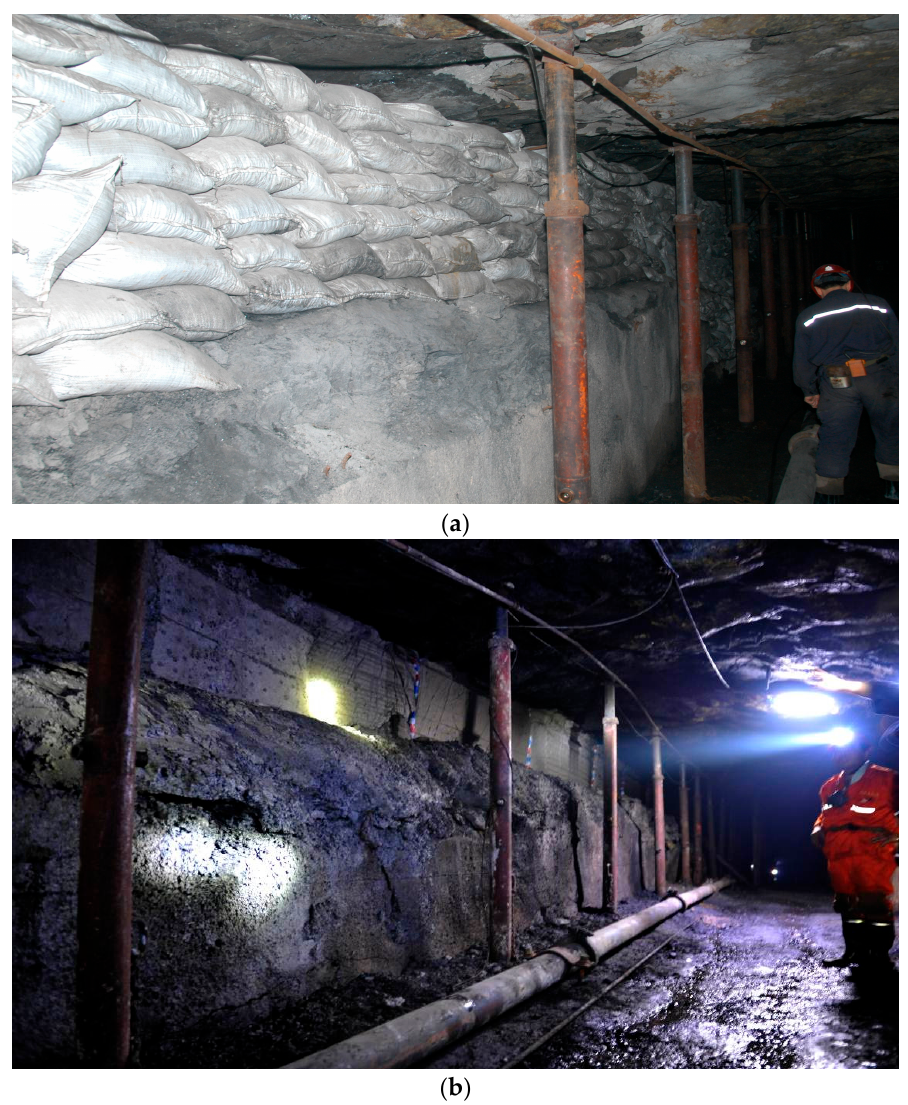
Figure 12. Photos of gob-side entry retaining: ( a ) Gob-side entry retaining with a bagged gangue wall; ( b ) Gob-side entry retaining with filling material.